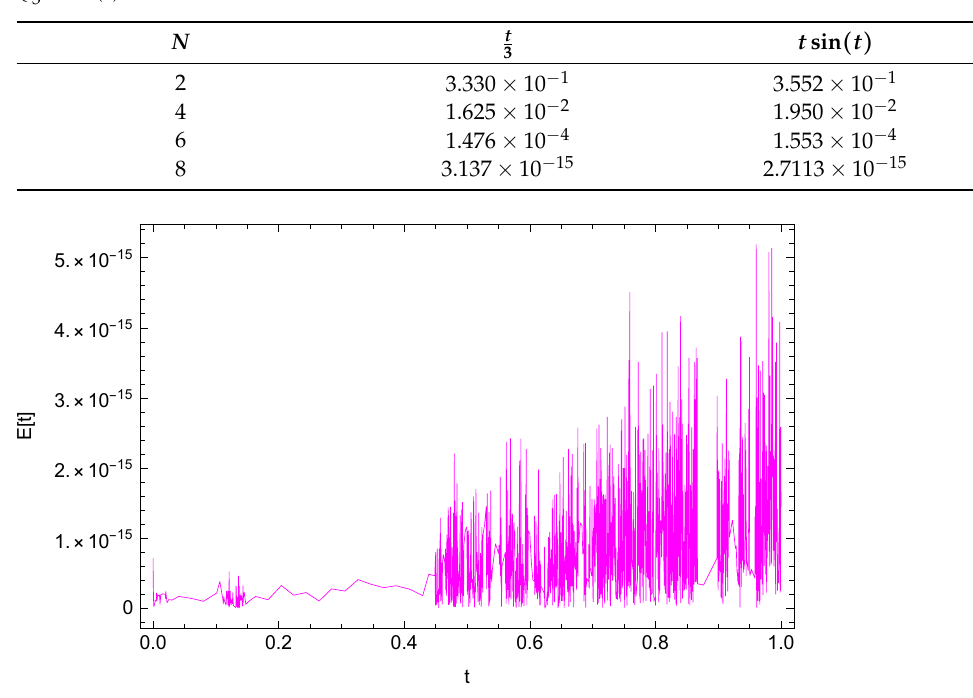
) and δ ( t ) = t , ( σ , ρ ) = ( 0, 1 2 2 3